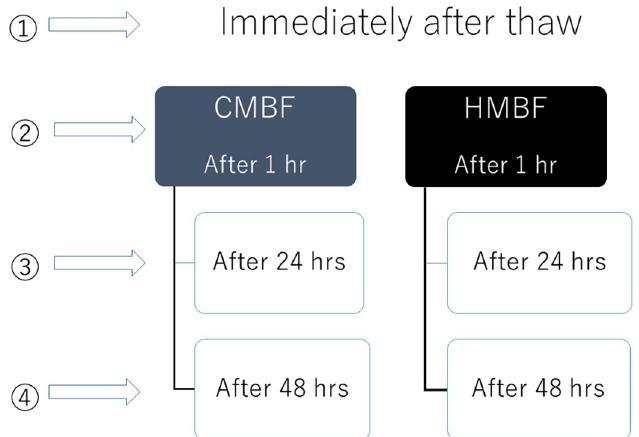
Fig 1. The timing of particle size measurement. Timing of Particle Size Measurement. MFG size measurements were taken at four times: baseline upon thawing before fortification, and 1, 24, and 48 hours after fortification.